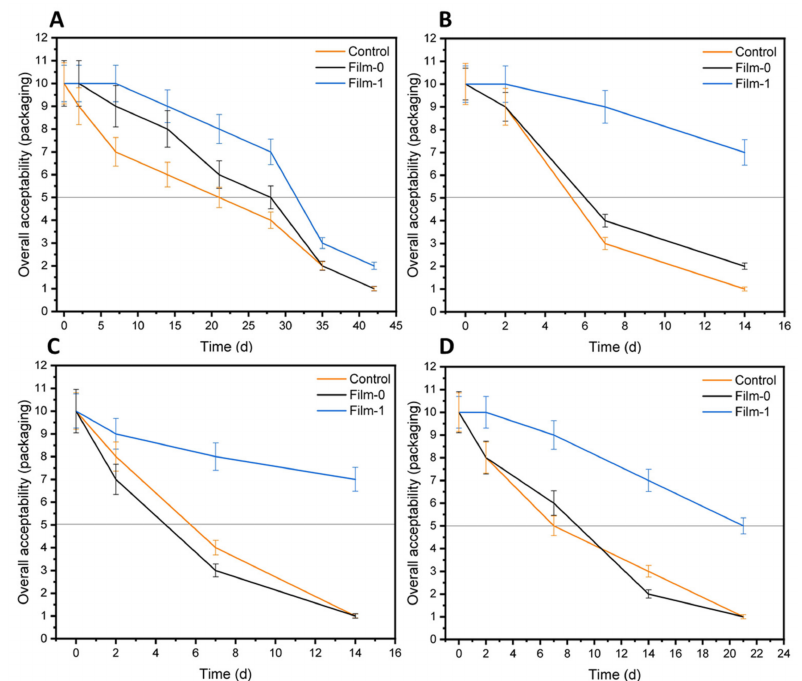
Figure 11. Evaluation of overall acceptability of uncoated tomatoes (control), BC-coated tomatoes (Film-0), and BC/CMC/Gly/yeast-coated tomatoes (Film-1) stored at ( A ) 6 ◦ C, ( B ) 40 ◦ C, ( C ) 30 ◦ C, and ( D ) room temperature (20 to 25 ◦ C) for different time